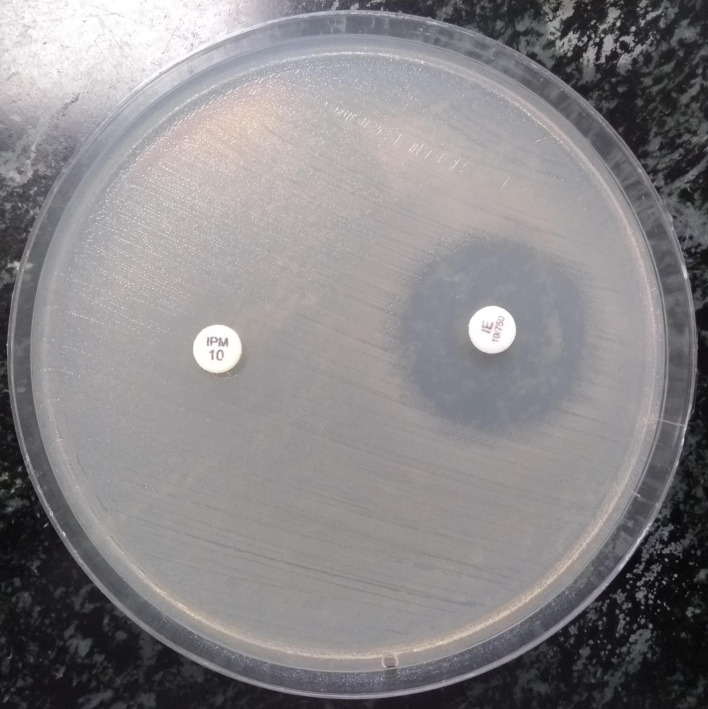
Enhancement of zone of inhibition by >7 mm with imipenem-EDTA antibiotic disc compared to imipenem disc alone (phenotypically positive for MBL enzyme).